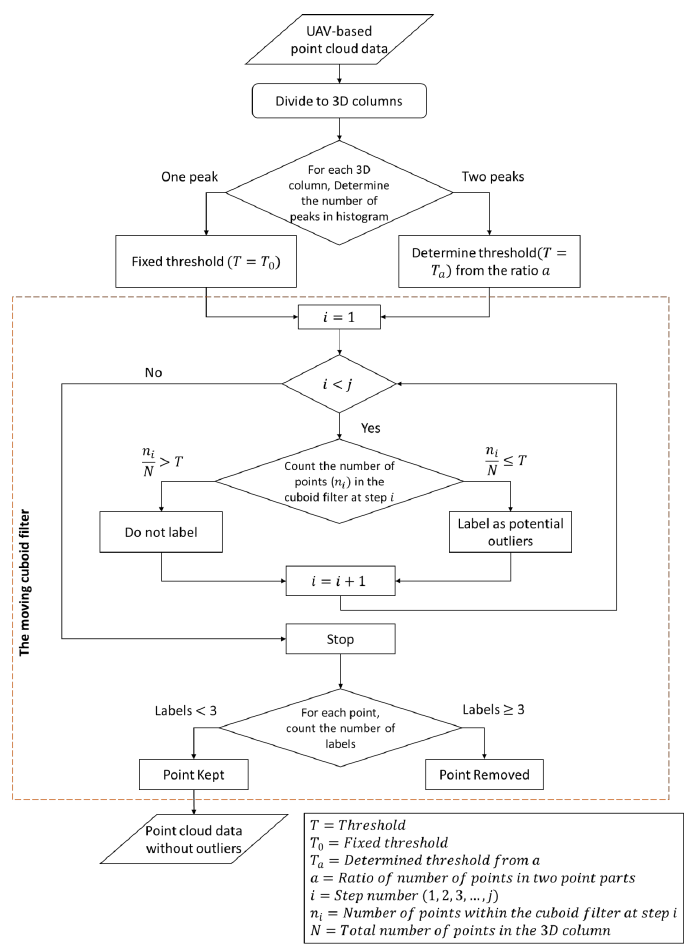
Figure 6. Flow chart of the moving cuboid filter.